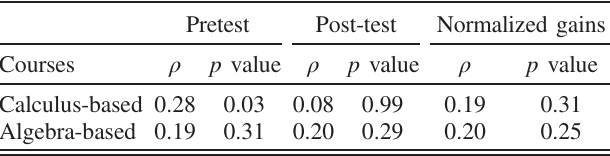
TABLE VI. 2-sample KS test results by gender. Pretest Post-test Normalized gains